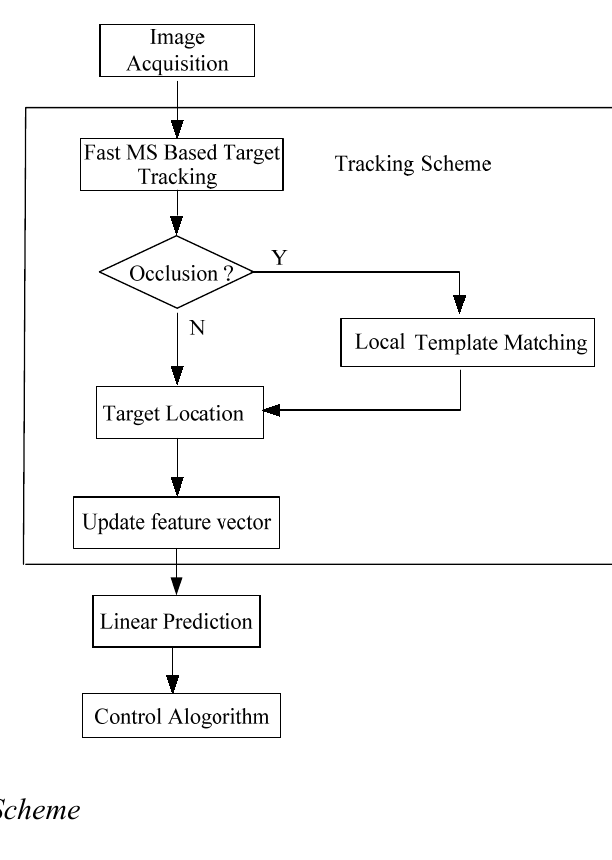
Figure 5. The structure of the TTS software